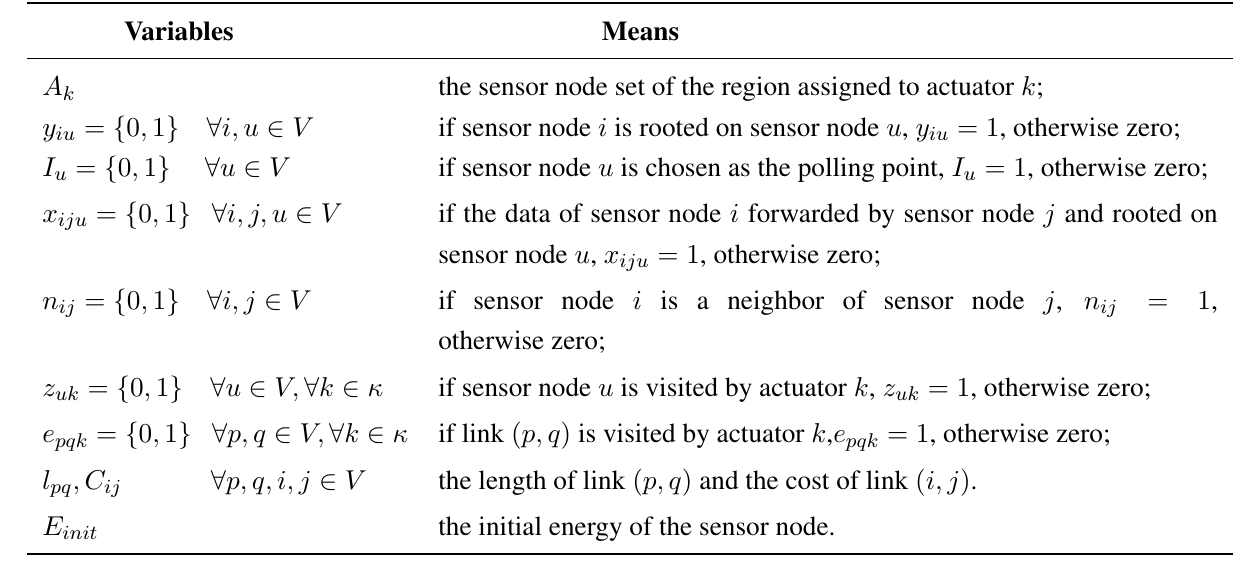
Table 1. Notations